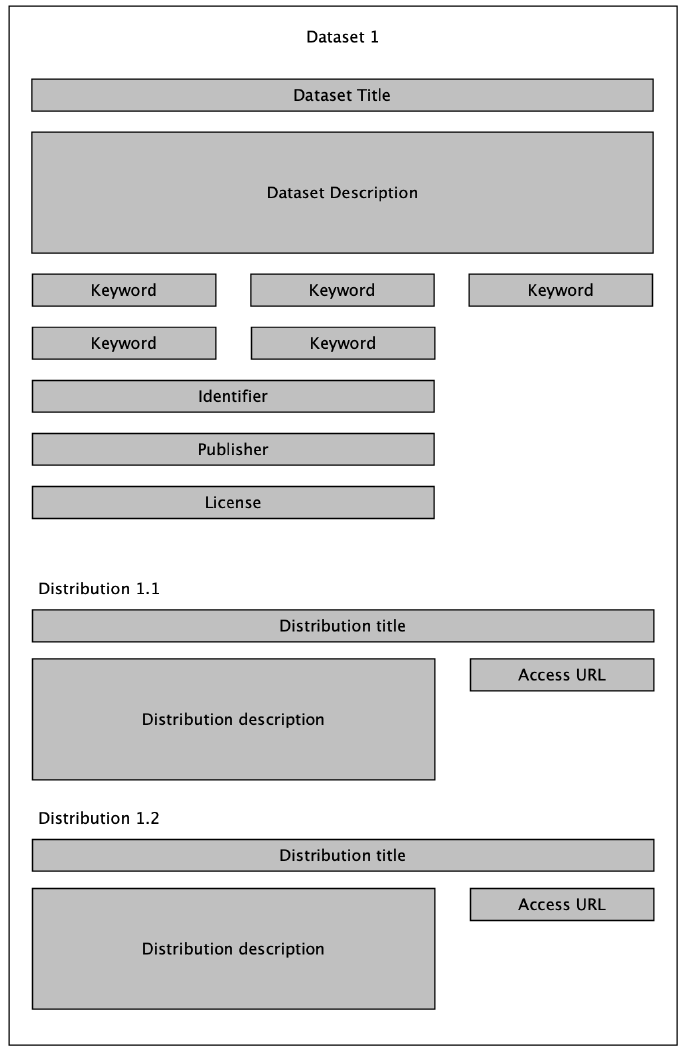
Figure 2: Partially overview about a DCAT-AP dataset and its